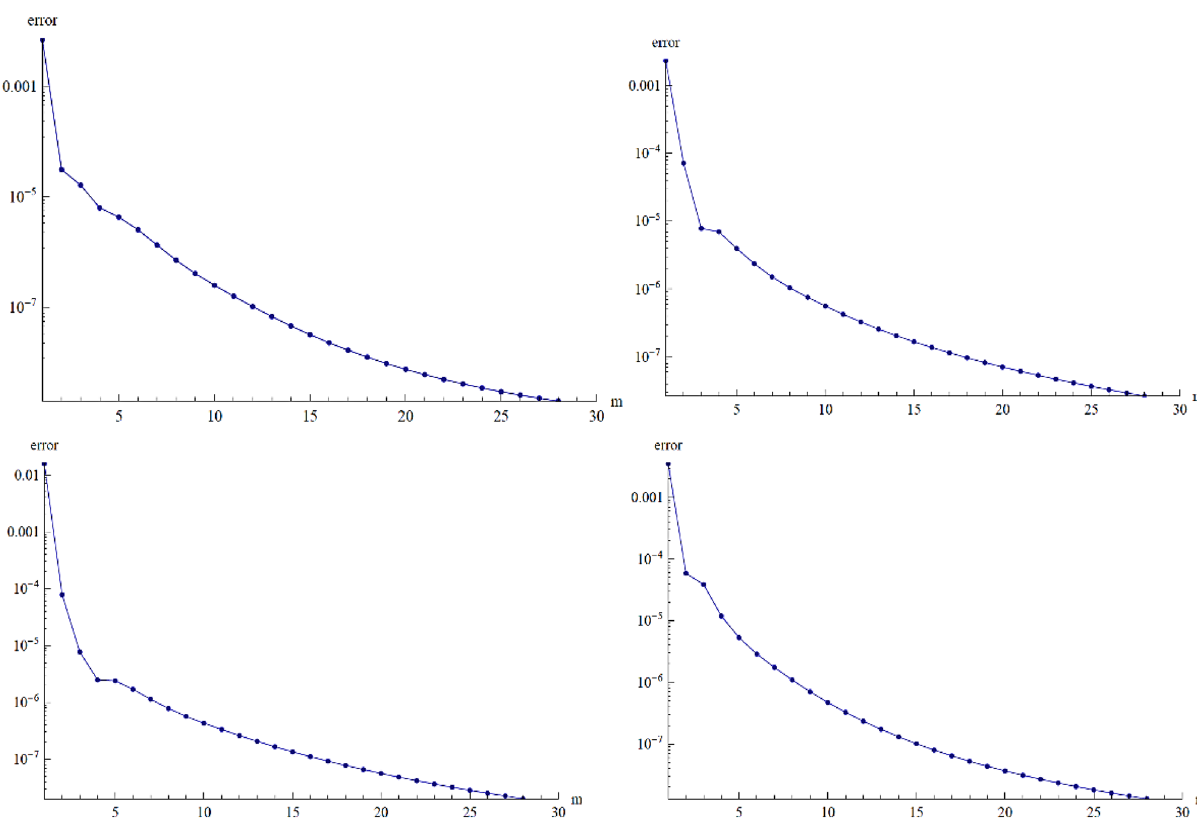
Figure 18. Residual error for velocity, energy and concentration